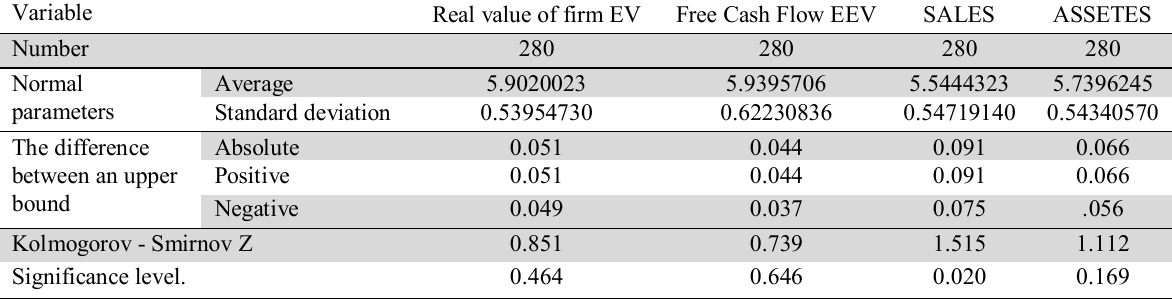
Summary of results for normality test of transformed variables